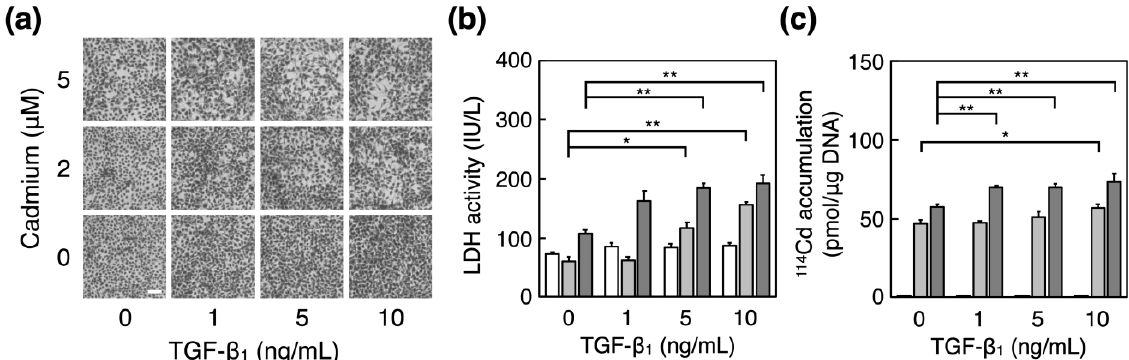
Figure 1. Influence of TGF- β 1 on cadmium-induced cytotoxicity of vascular endothelial cells. Bovine aortic endothelial cells that were treated with or without TGF- β 1 (1, 5, or 10 ng/mL) for 24 h were incubated in the presence or absence (white bars) of cadmium at 2 μM (thin gray bars) or 5 μM (dark gray bars) for 24 h. ( a ) This panel shows the cell layer stained with Giemsa. Original magnification (×40). Scale bar = 100 μ m. ( b ) This panel shows the conditioned media used to determine lactate dehydrogenase activity, and ( c ) the intracellular accumulation of cadmium, which was measured using inductively coupled plasma-mass spectrometry. Each value represents the mean ± standard error (S.E.) of four independent experiments; and statistical significance compared to the corresponding cadmium-exposed cells without TGF- β 1 was set as * p < 0.05, ** p < 0.01.